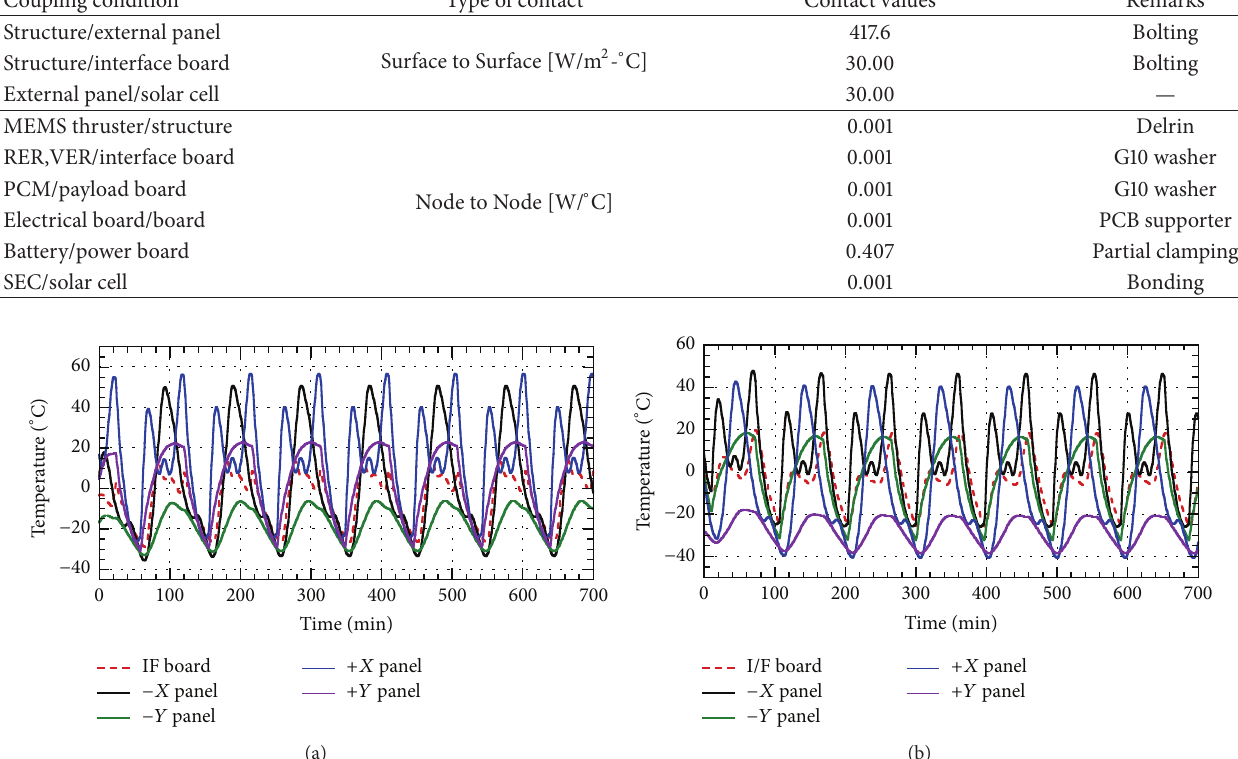
Figure 10: Temperature profiles of external panels ((a) worst hot case, (b) worst cold case).